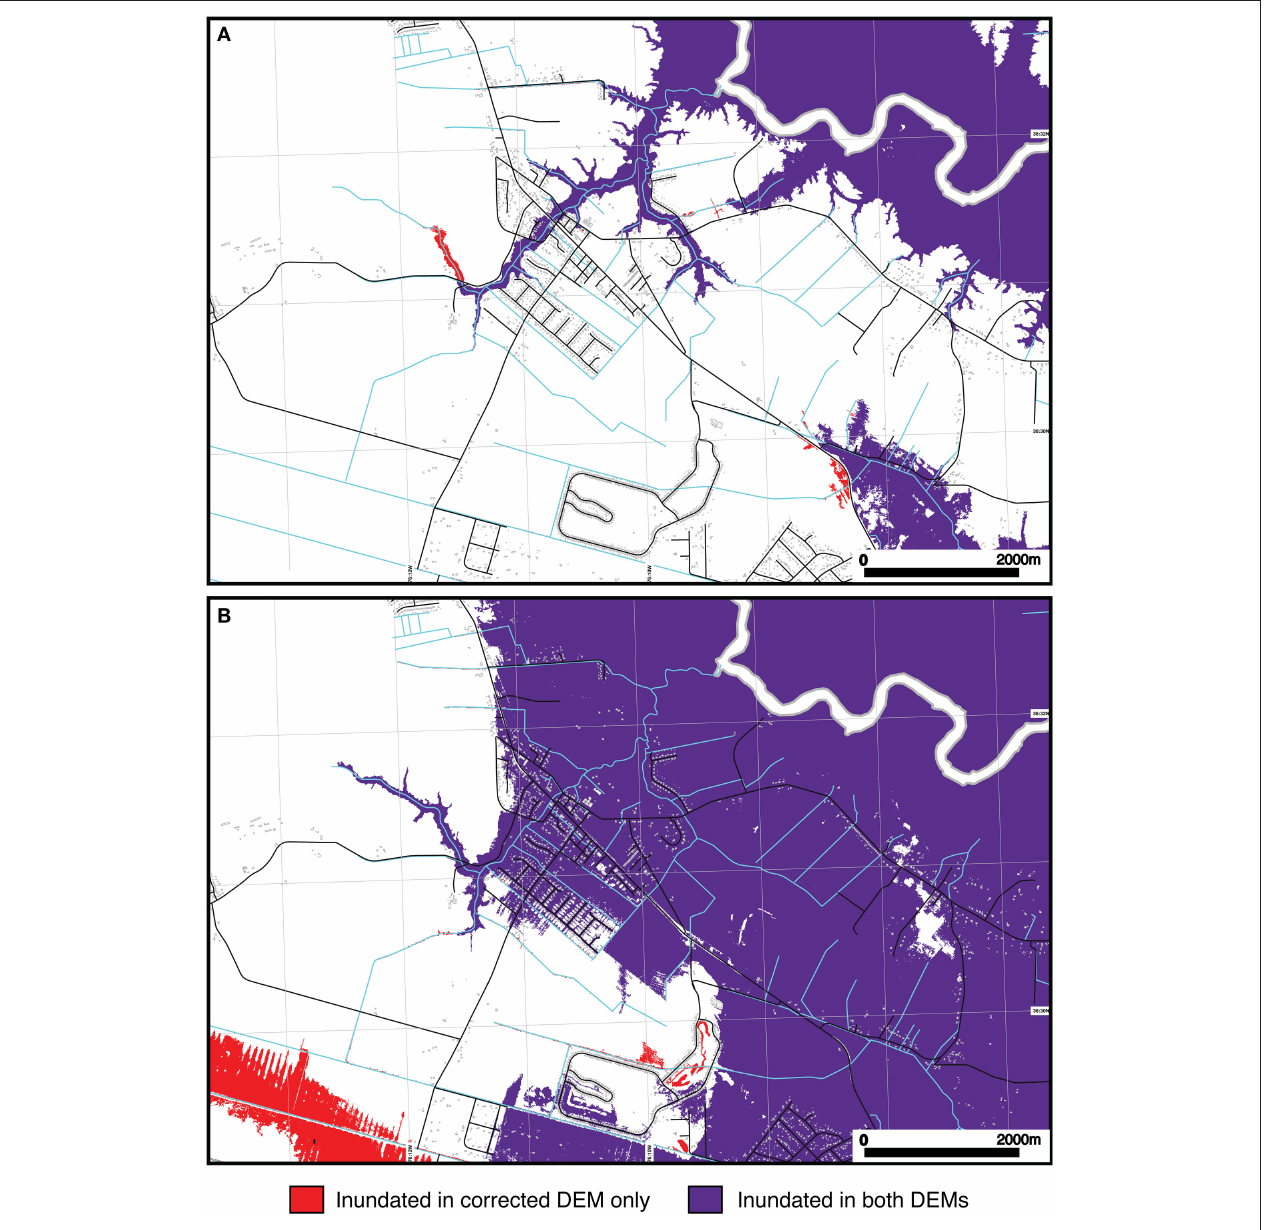
FIGURE 5 | Maps comparing the areas inundated in two source connectivity ensured hydrologic inundation scenarios with both the original and hydro-corrected DEMs. (A) Base level scenario with water surface at mean sea level; (B) 2.75m water rise scenario, illustrating areas in red where the hydro-conditioned DEM highlights potential upland inundation from a storm surge that would be omitted in a raw bare earth DEM without hydro-correction and